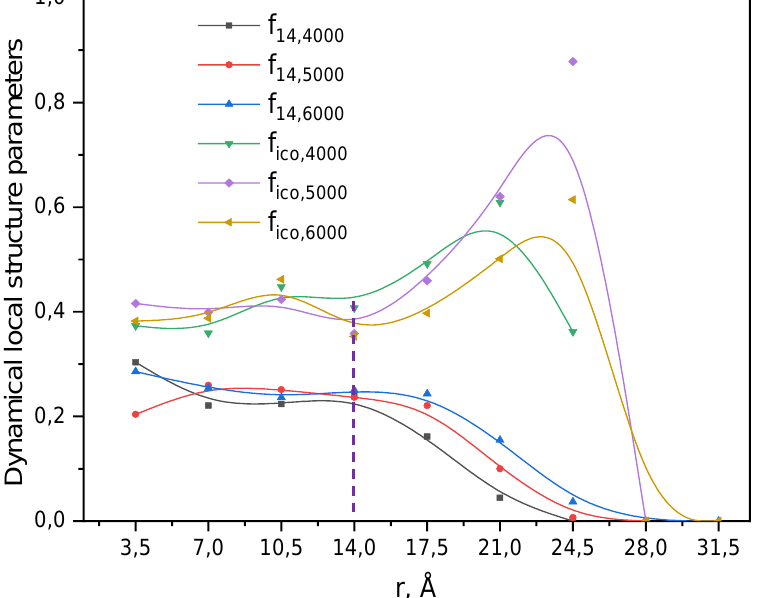
Figure 4. Dynamical local structure parameters <f14>, <fico> for 4000, 5000, 6000 atoms sample through concentric spherical layers at 300